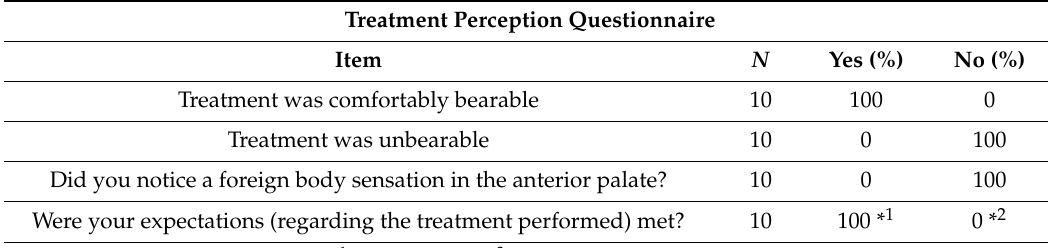
Table 2. Patient perception in relation to